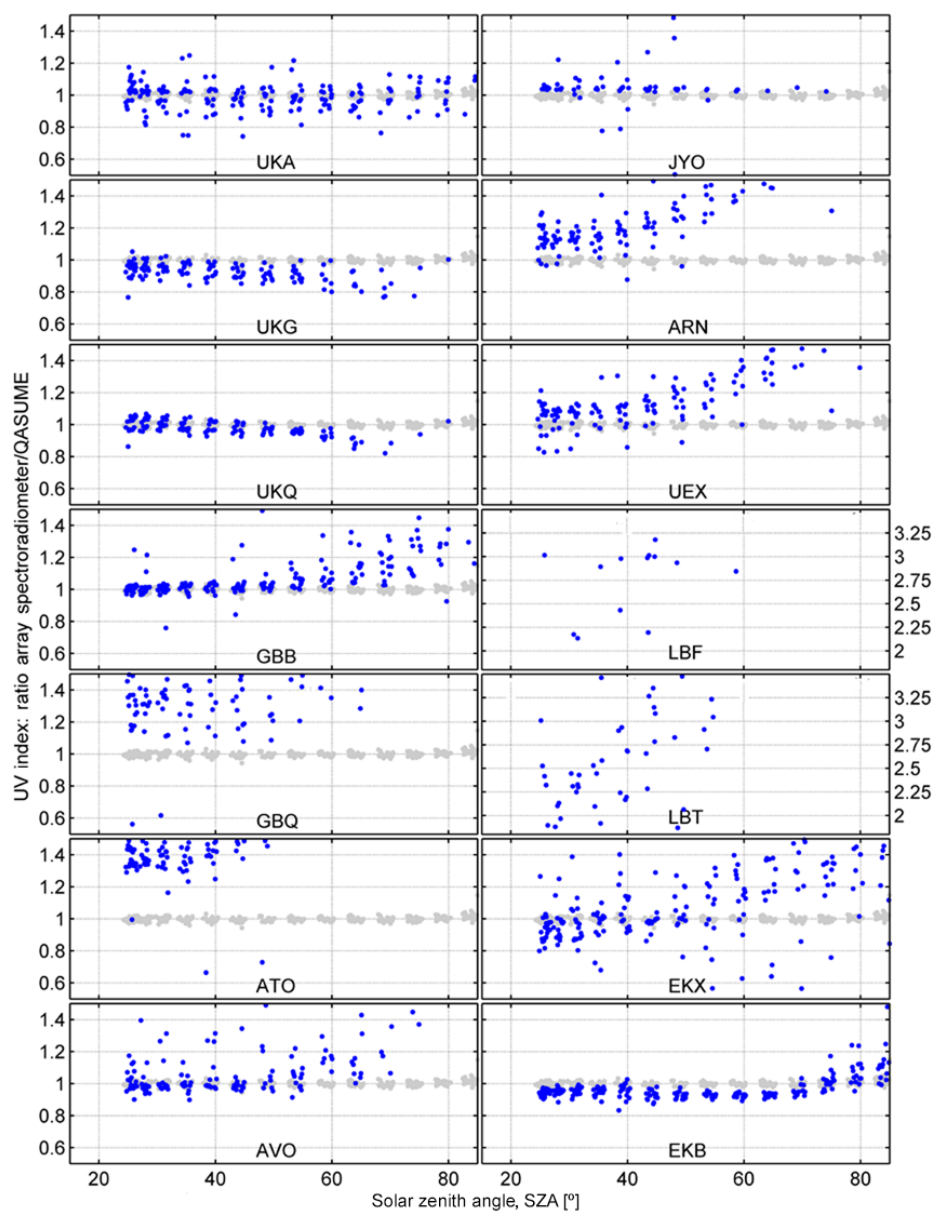
Figure 5. The ratios of UV indices derived from all array spectroradiometers (blue points) to the QASUME reference spectroradiometer, as a function of solar zenith angle. The grey points indicate the ratio between QASUME and QASUME II in order to display the determination of the UV index with double monochromator instruments. The y axis of LBF and LBT has been adjusted to display the